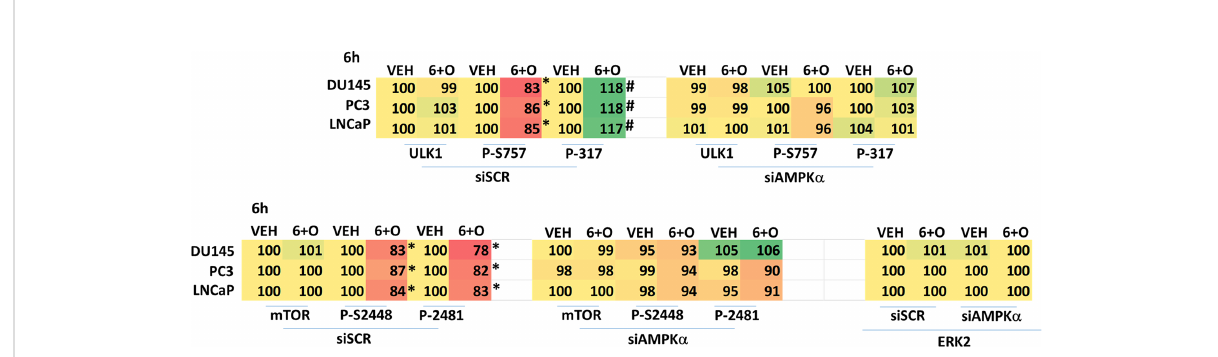
FIGURE 4 Regulation of ULK1 and mTOR by [GZ17-6.02 + olaparib] requires the AMPK. Cells were transfected with a scrambled siRNA or with an siRNA to knock down expression of AMPK a . After 24h, cells were treated with vehicle control or [GZ17-6.02 (2 m M) and olaparib (50 nM)] in combination for 6h. Cells were fi xed in situ, permeabilized, stained with the indicated validated primary antibodies and imaged with secondary antibodies carrying red- and green- fl uorescent tags. The staining intensity of at least 100 cells per well/condition is determined in three separate studies. The data are the normalized amount of fl uorescence set at 100% comparing intensity values for vehicle control (n = 3 +/-SD). # p < 0.05 greater than vehicle control; *p < 0.05 less than vehicle control.